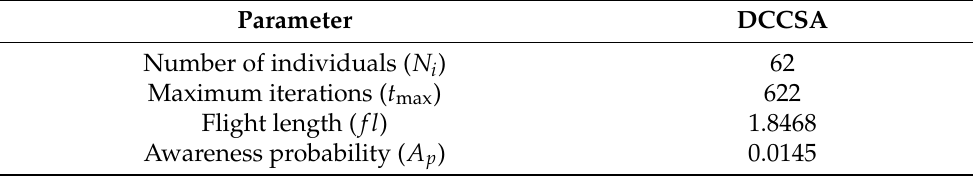
Table 2. Parameters of the discrete-continuous crow search algorithm used in the master